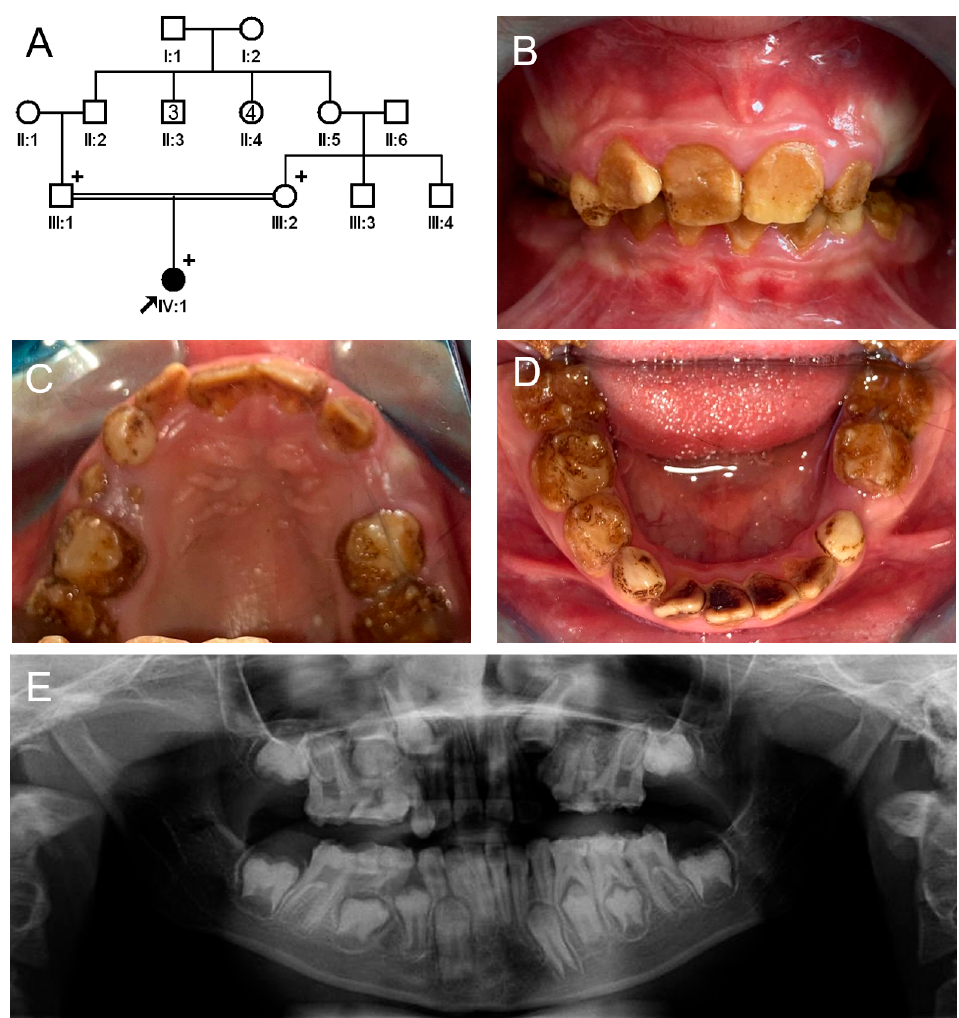
Figure 7. Pedigree, clinical photos, and panoramic radiograph of family 4. ( A ) Pedigree of family 4. The black symbol indicates the affected individual, and the proband is indicated by a black arrow. A plus sign above the symbol indicates participating individuals. The number inside the symbol indicates the number of siblings with the same gender. ( B – D ) Clinical photos of the proband at age 10 years. Permanent and deciduous dentitions show dark brown discoloration and exhibit enamel fractures and accelerated attrition. Black external stain is observed on most teeth. ( E ) A panoramic radiograph of the proband at age 10 years shows irregular crown surfaces and enamel with reduced radiopacity and fractures. However, the developing crowns are normal in shape.